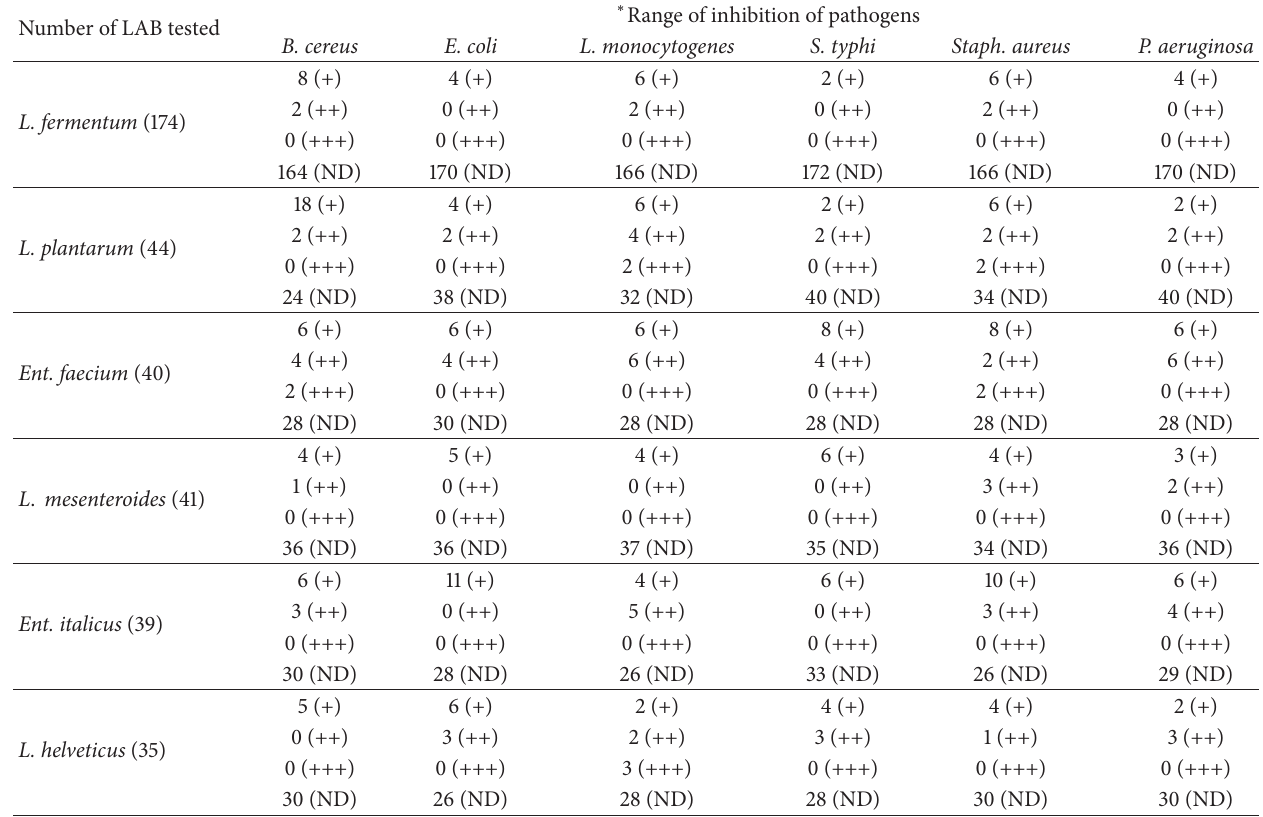
Table 3: Antimicrobial activities of predominant LAB against selected pathogenic microorganisms. Number of LAB